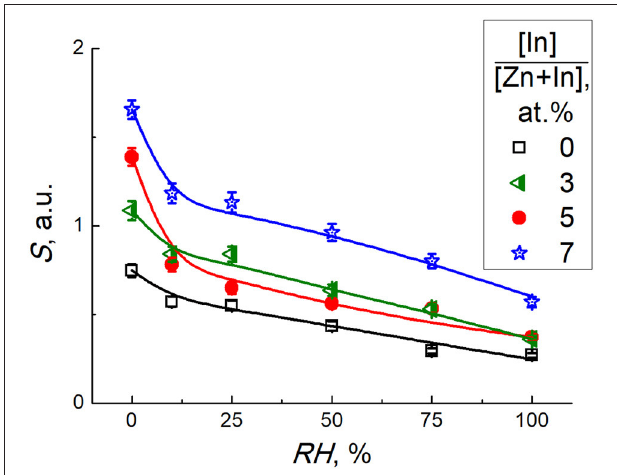
FIGURE 10 | Sensor signal of zinc oxide modified by different amounts of In 2 O 3 to 5 ppm CO at temperature 450 ◦ C and different relative humidity.